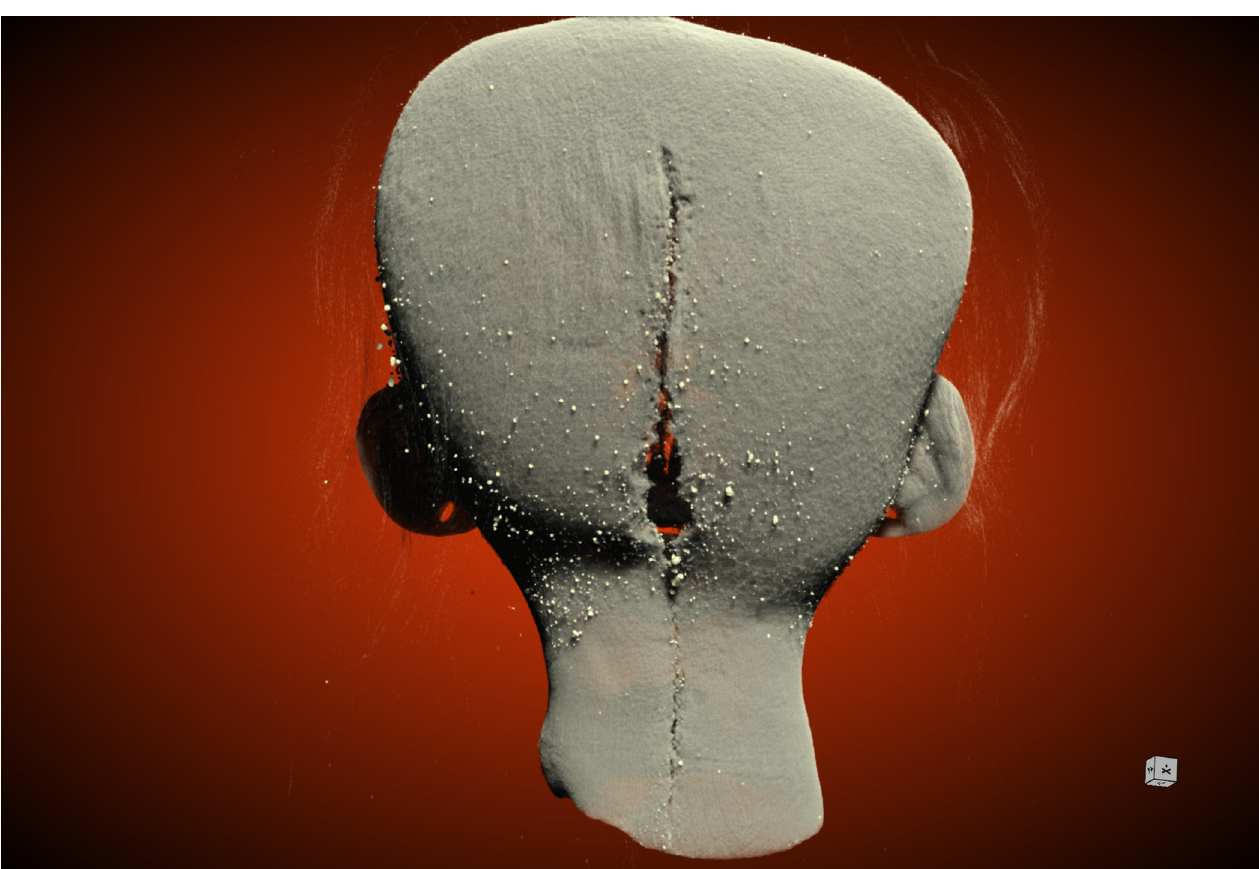
Fig 2. Digital visualization of the posterior incision and stitching. Micro-CT image of the incision at the rear of the skull, windowed and leveled to remove the